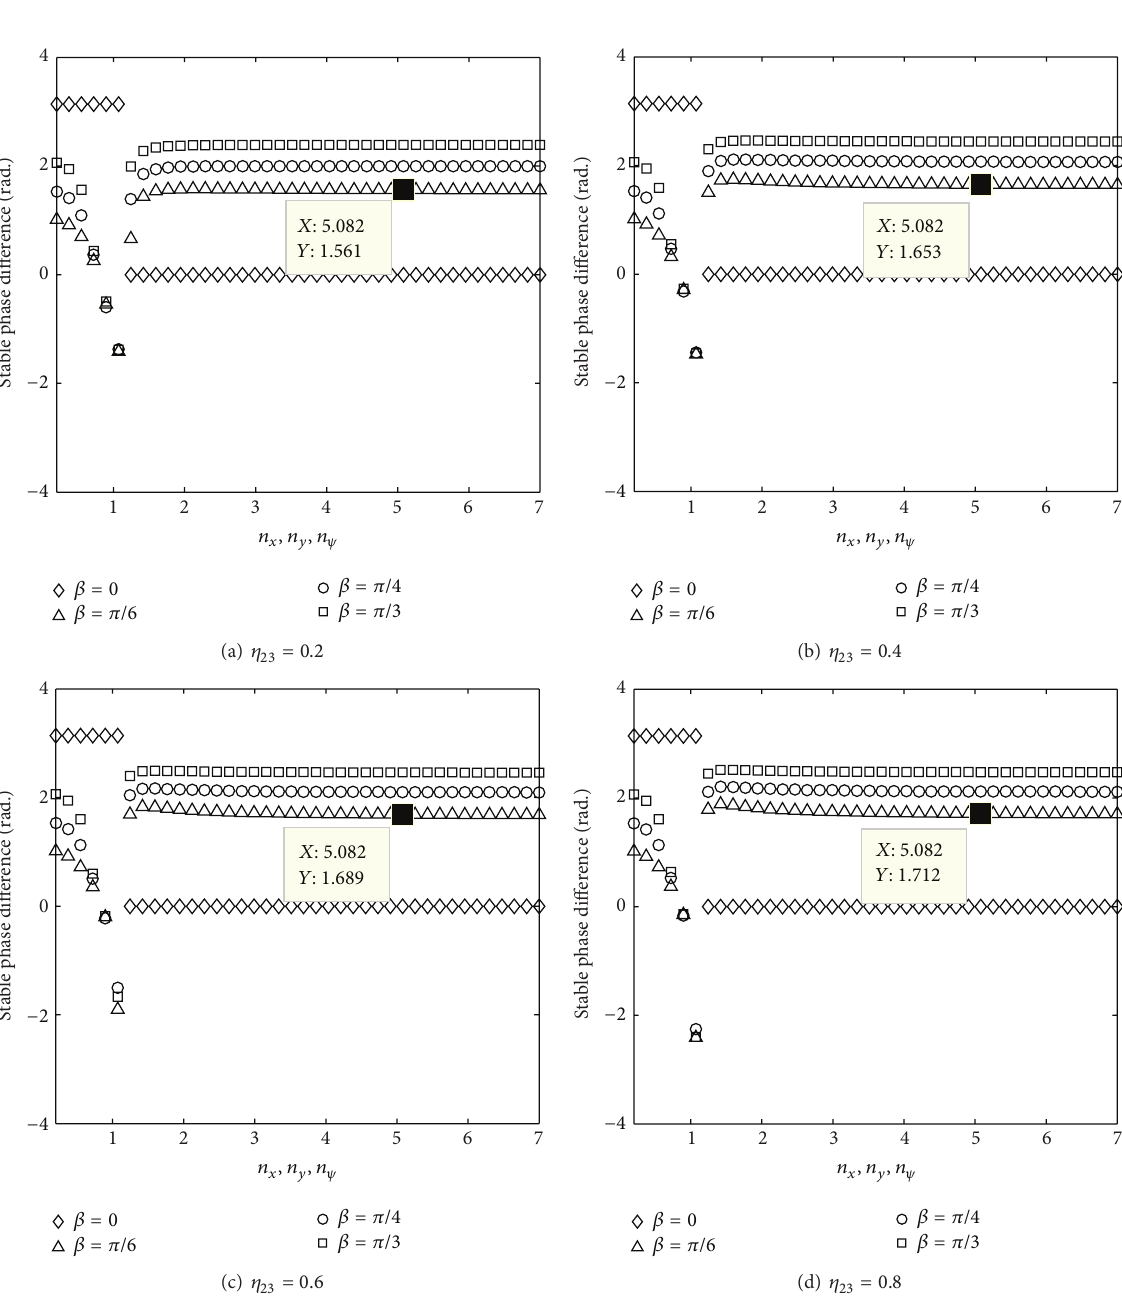
= 0.2 , (b) 𝜂 = 0.4 , (c) 𝜂 = 0.6 , and (d) 𝜂 = 0.8 23 23 23 23